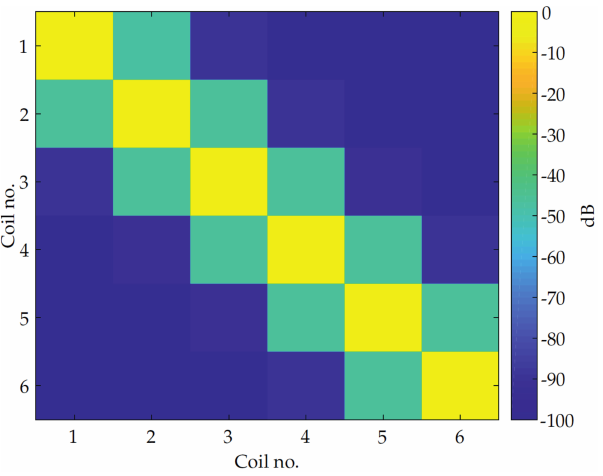
Figure 6. Cross correlation between individual equalized coil excitation